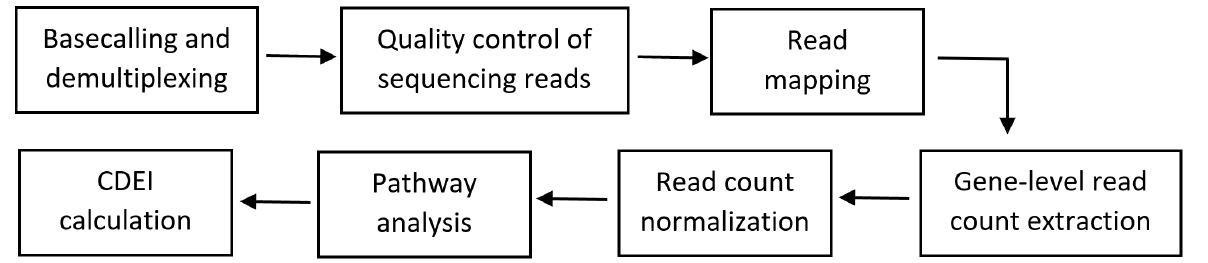
Figure 2. Bioinformatics workflow for the cannabis drug efficiency index (CDEI) calculation.